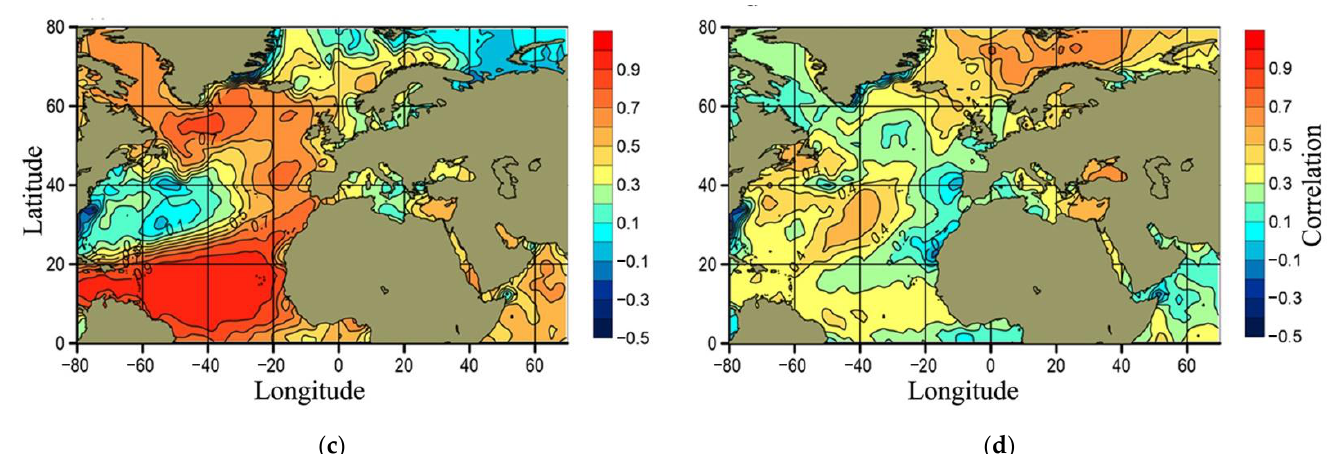
Figure 4. Correlation between annual SST anomalies in the tropics of the North Atlantic, NAO, and SST in the rest of the North Atlantic. Upper panel — composites of annual mean SST anomalies corresponding to anomalous mean annual values of the NAO index in 1950 – 2015: ( a ) SST with anomalous negative NAO indices, ( b ) with anomalous positive NAOs. The lower panel shows correlations between annual SST anomalies in the tropical region of the North Atlantic and annual SST anomalies throughout the entire water area in 1980 – 2015, ( c ) synchronous correlation, ( d ) with a lag of 3 years relative to SST in the tropics.